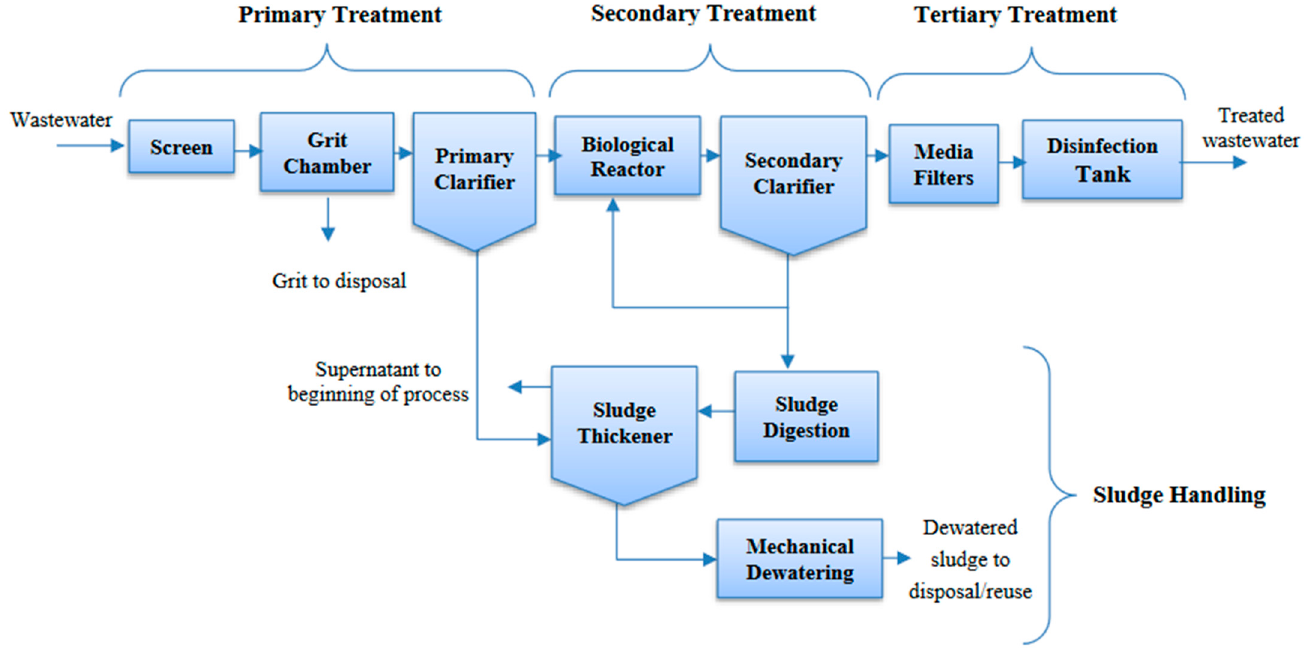
Figure 1. Layout of a conventional wastewater-treatment plant.